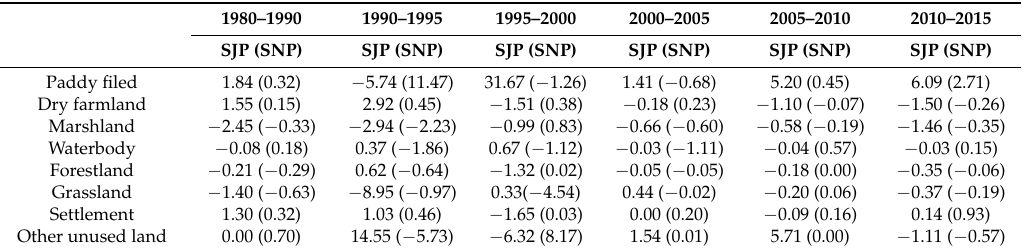
Table 5. Dynamic degree (%) of certain LULC type between 1980 and